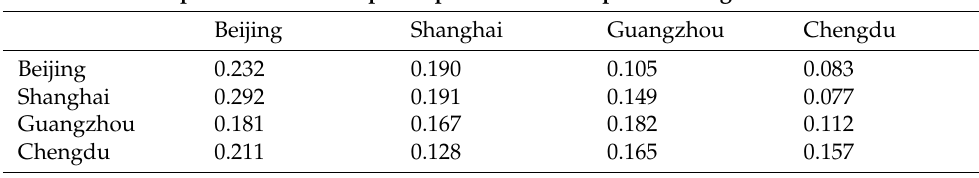
Table 6. Spillover effects of per capita GDP on airport passenger/cargo traffic (Beijing, Shanghai, Guangzhou, and